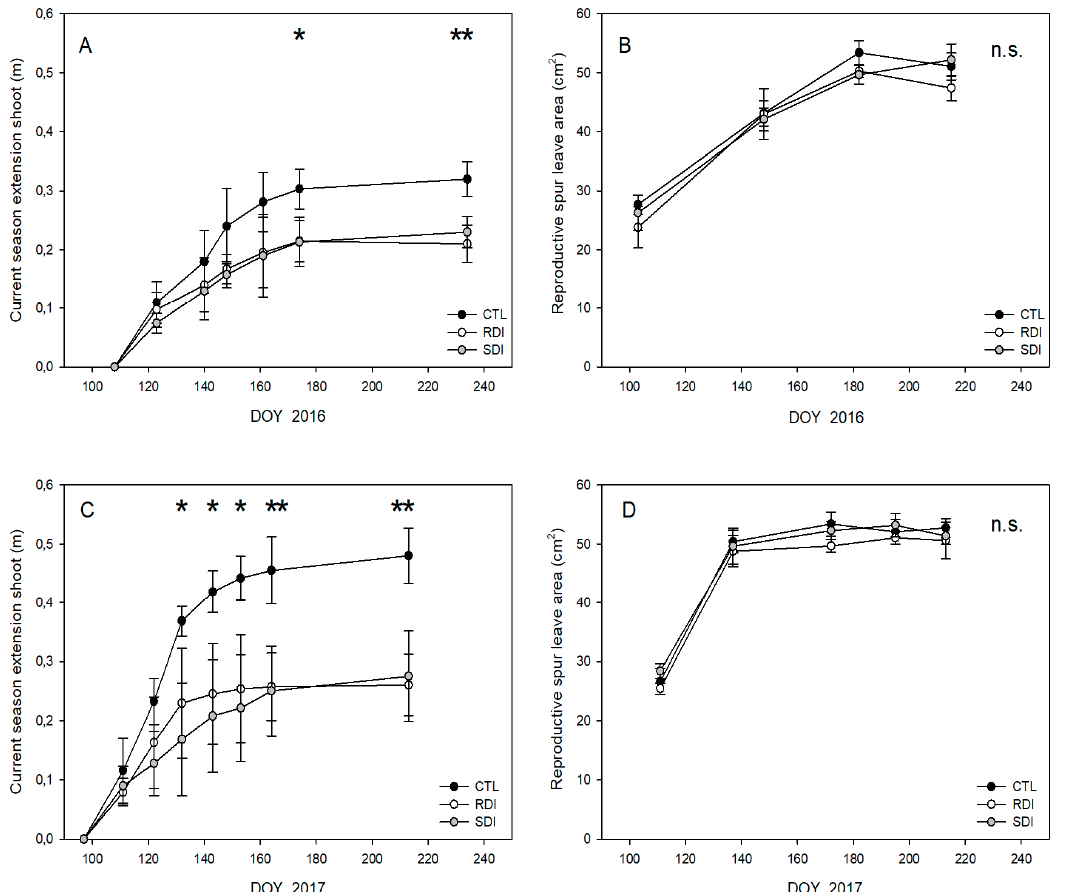
Figure 2. Seasonal evolution of accumulated length of current season shoots ( A , C ) and reproductive spur leaf area ( B , D ) of ‘Prime Giant’/SL64 sweet cherry combination for 2016 and 2017 seasons to CTL, RDI and SDI irrigation treatments. Each observation corresponds to an average value for each treatment (n = 4). * and ** refer to significant effects at each time according to ANOVA ( p < 0.05 and 0.01, respectively). n.s. refers to not significant differences.